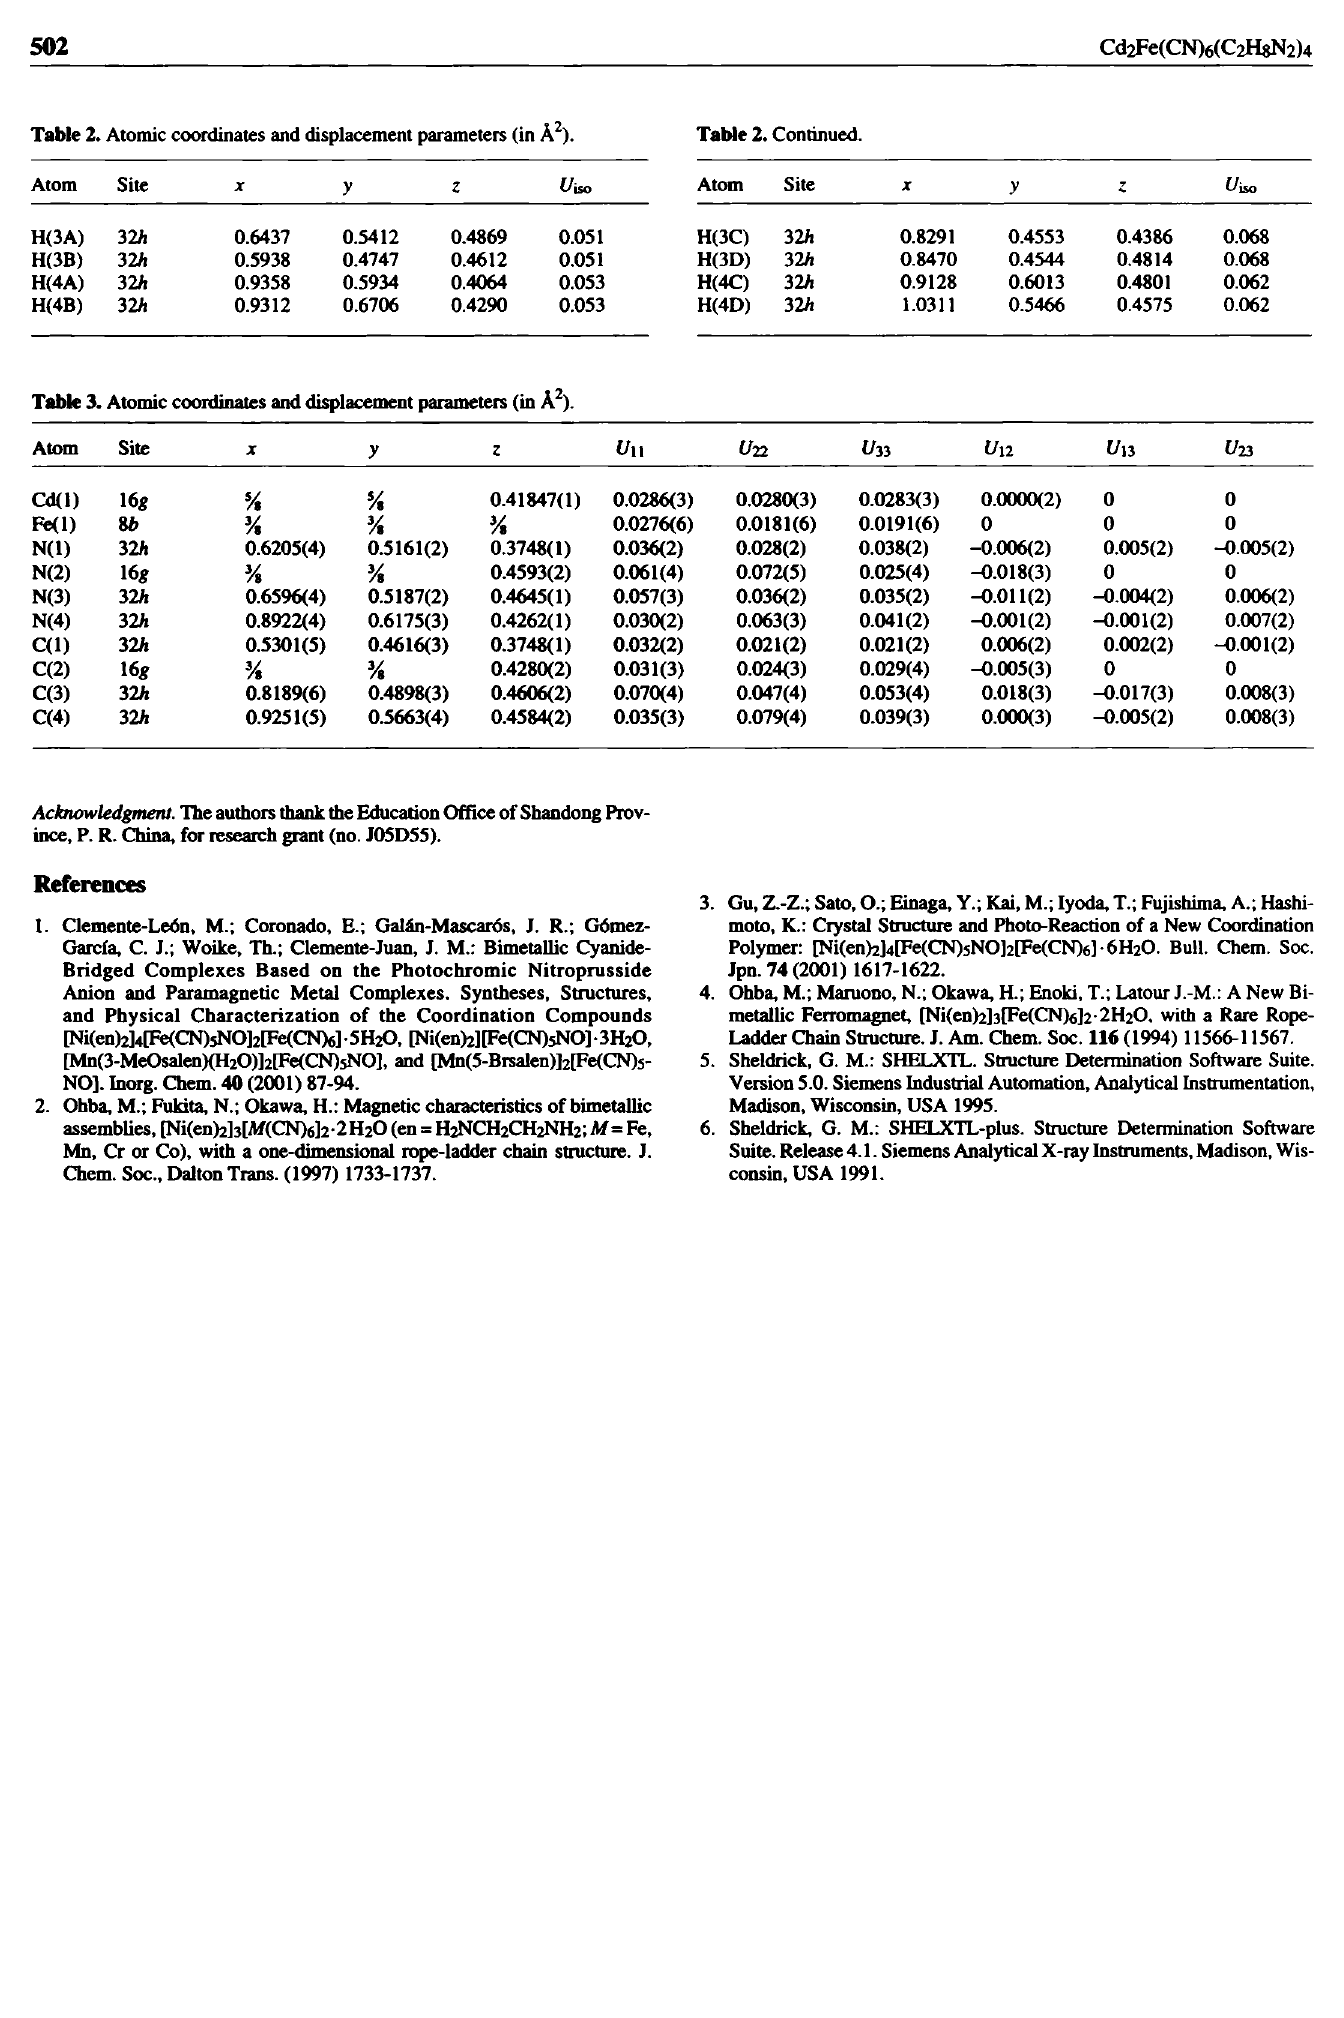
Table 2. Atomic coordinates and displacement parameters (in Ä 2 ).